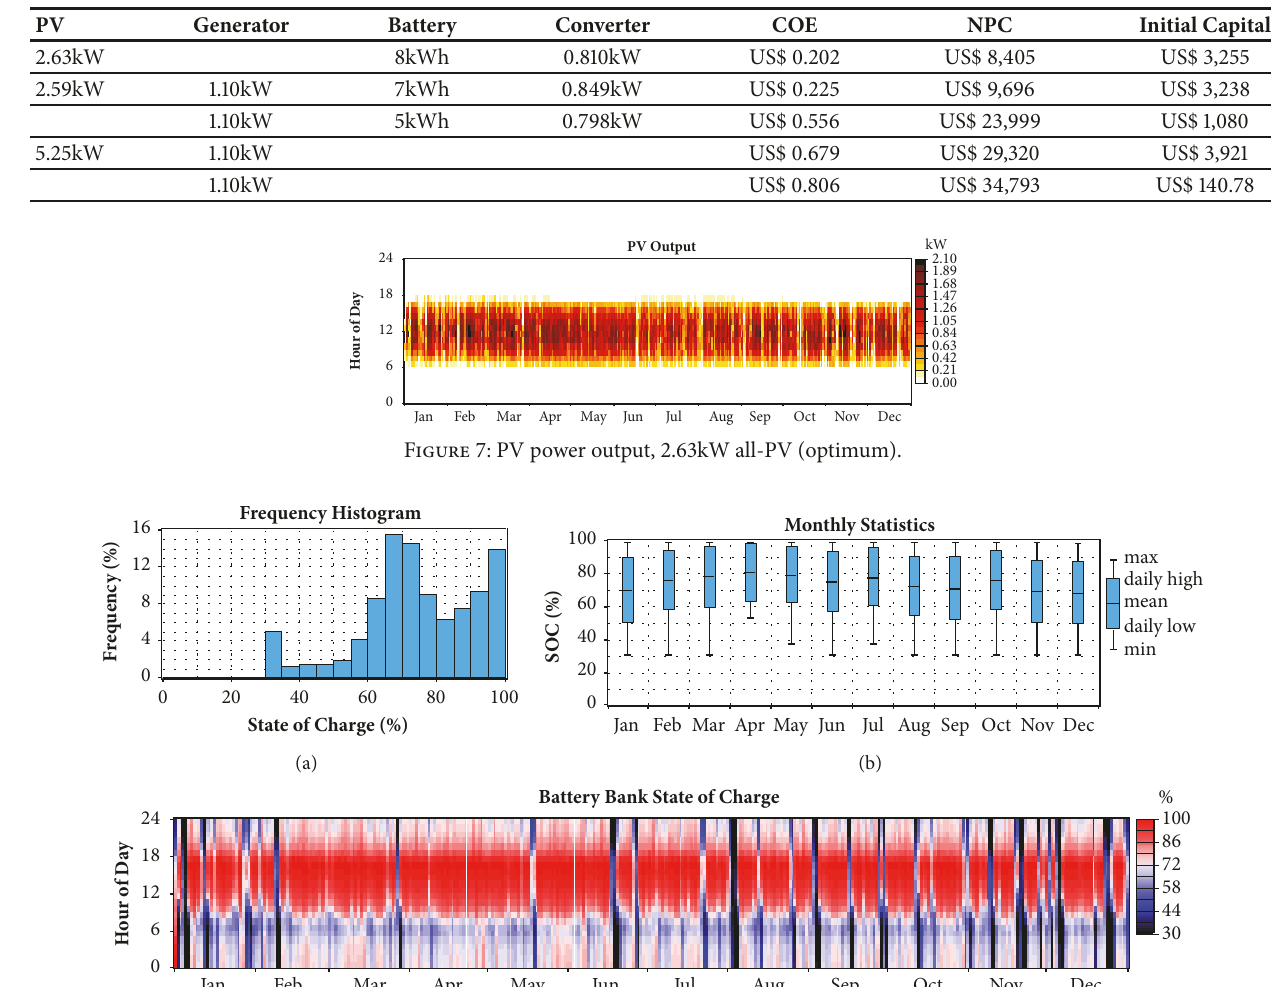
Table 1: Feasible configurations at 5.35 kWh/day load demand.